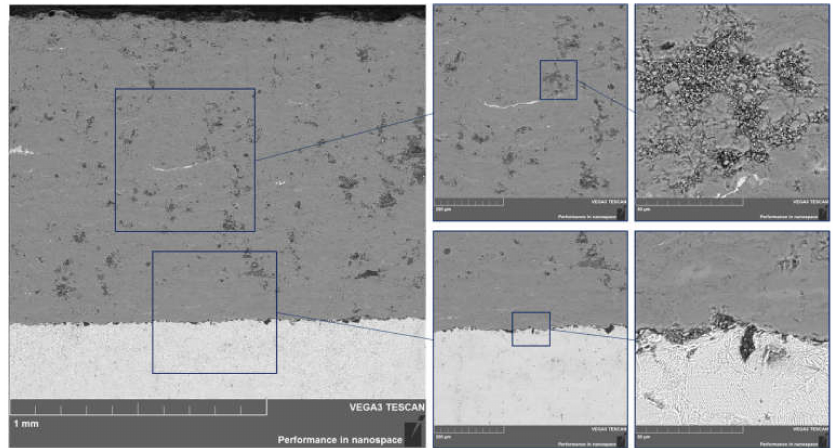
Figure 4. SEM image of the cross-section of the initial coating on based Ti 3 SiC 2. The microstructure of the cross-section of the coating after pulsed-plasma treatment depending on the distance from the plasmatron is shown in Figure 5. The upper layer contains a molten, plasma-modified extremal layer 20–25 µ m in thickness (Figure 5). As a result of pulsed-plasma treatment, the chemical composition of the surface of the Ti–Si–C coatings was changed.